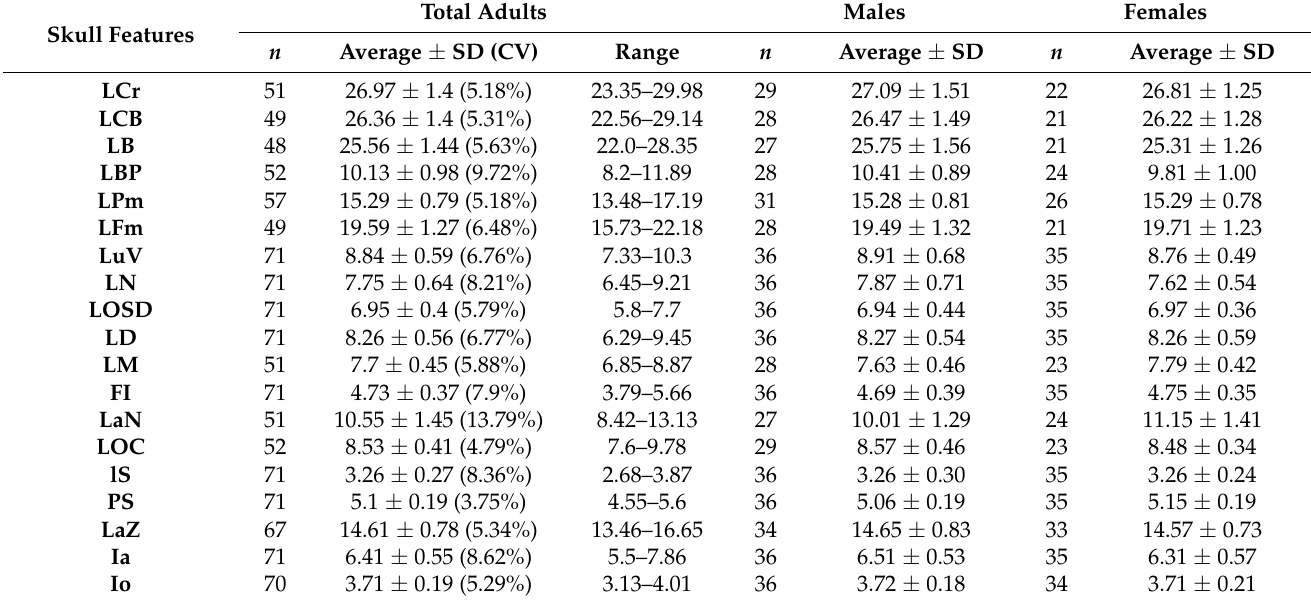
Table 5. Cranial signs in adult Pannonian root vole.